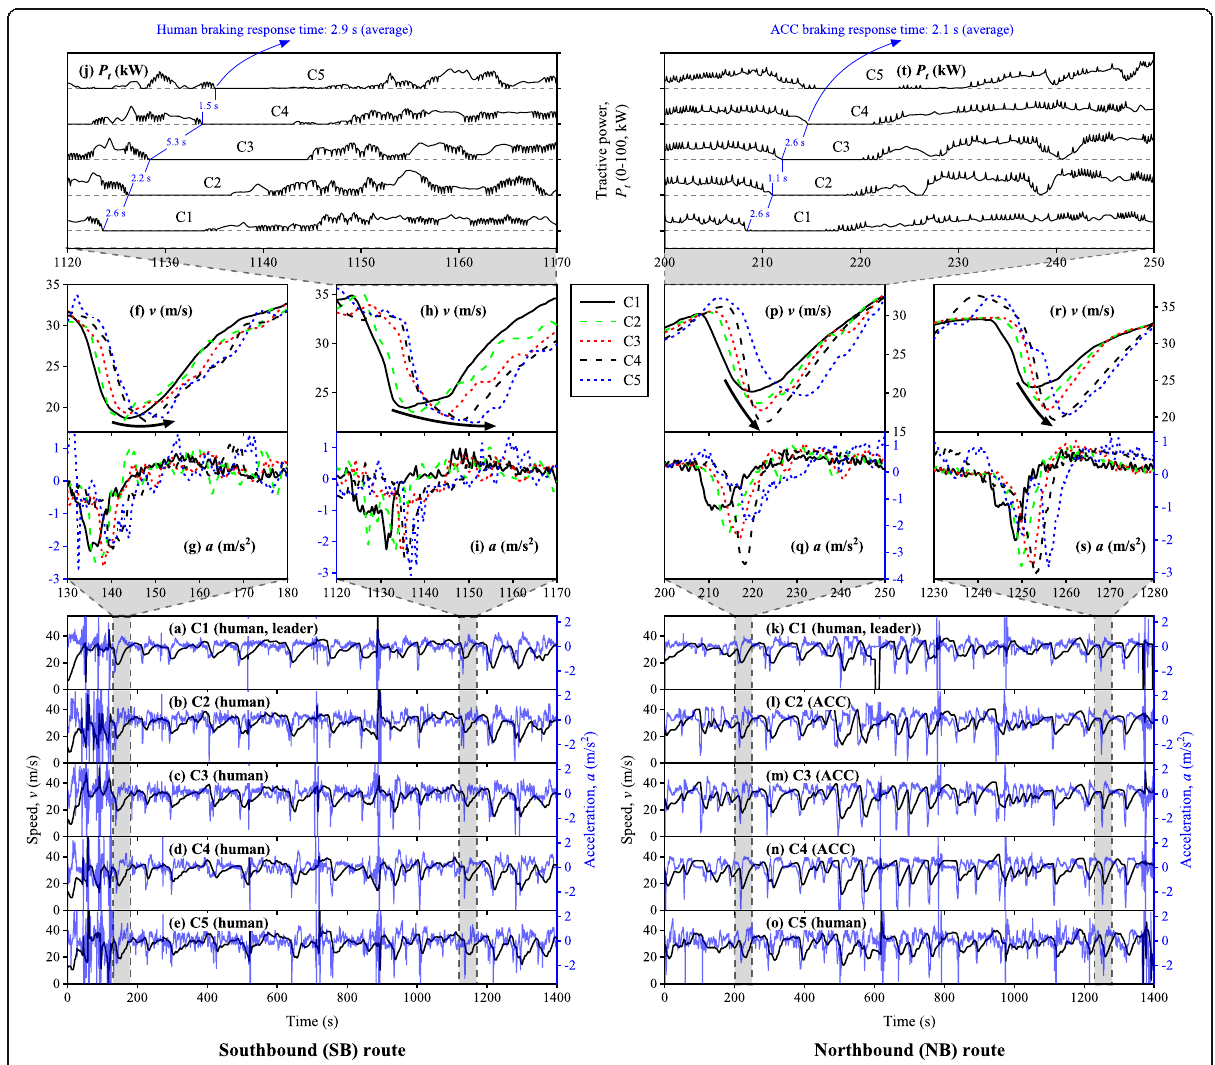
Fig. 3 Speed, acceleration and tractive power of test vehicles on the SB and the NB routes